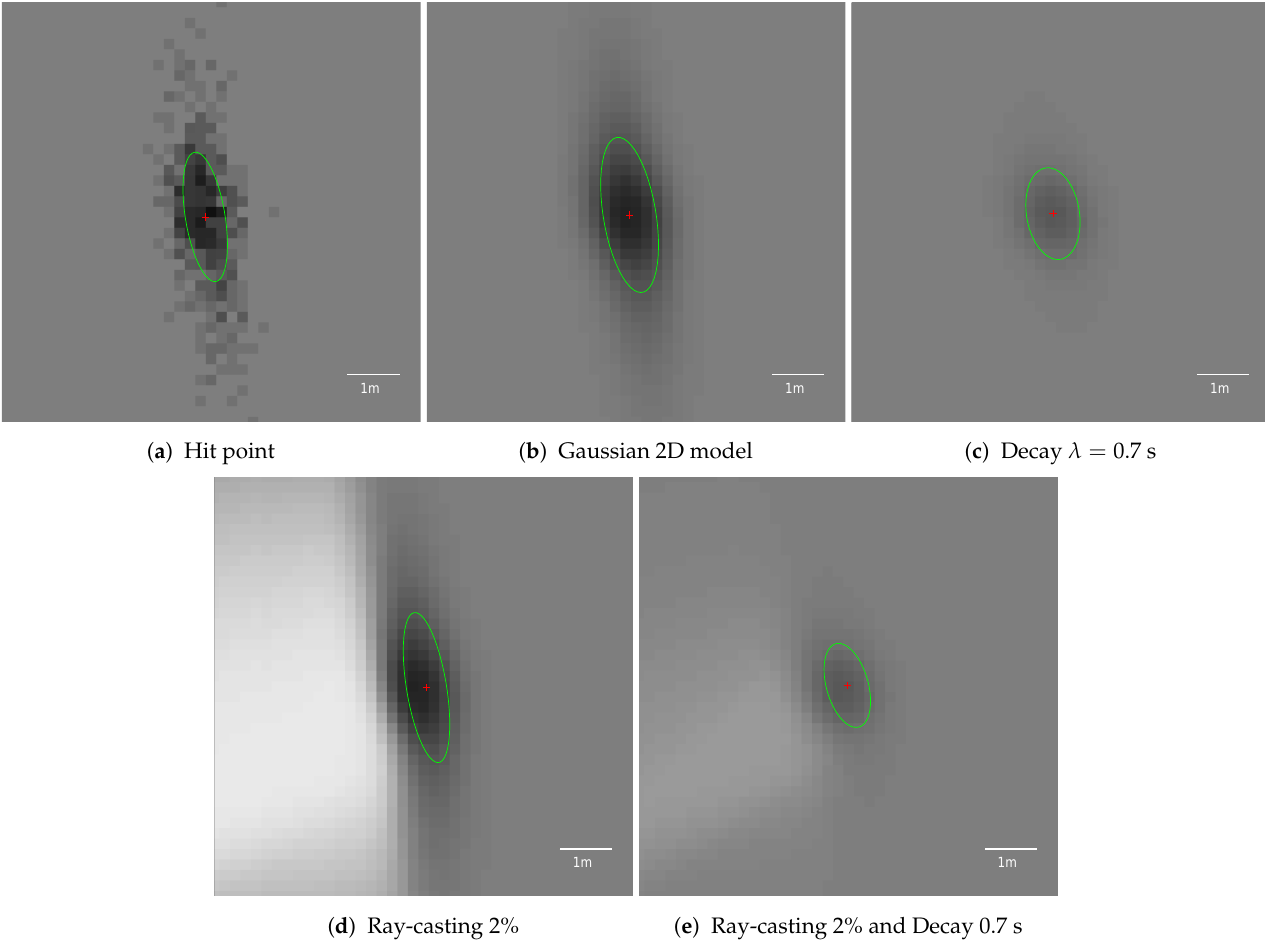
Figure 17. Averaged occupancy grid representations of the pole using different filtering methods. Each snapshot presents the pole located 10 m from the left side of the vehicle, captured when the host was 10 m away from the pole